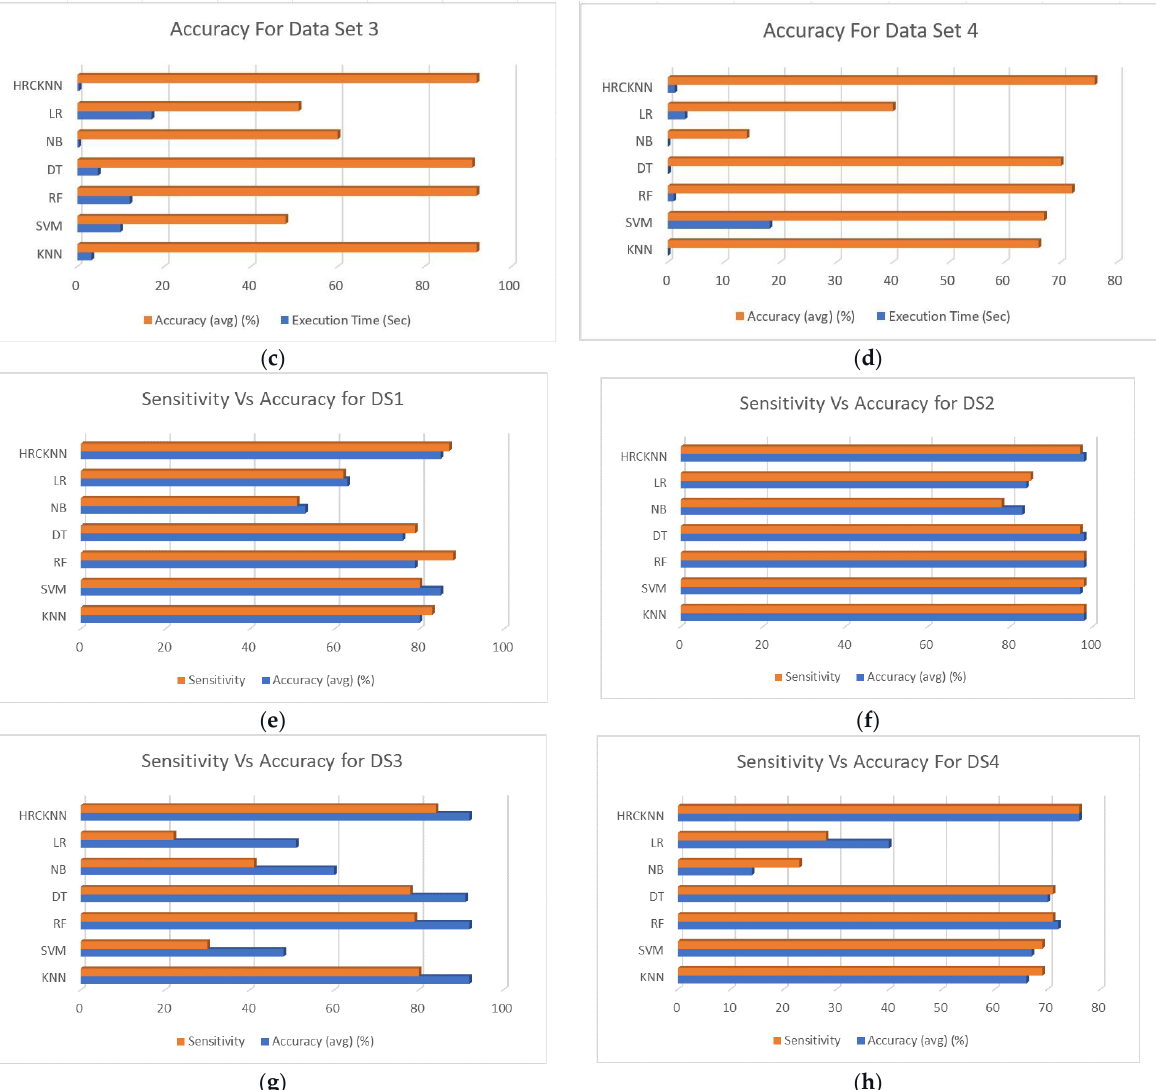
Figure 8. ( a ) Accuracy Vs. Execution Time for Dataset 1; ( b ) Accuracy Vs. Execution Time for Dataset 2; ( c ) Accuracy Vs. Execution Time for Dataset 3; ( d ) Accuracy Vs. Execution Time for Dataset 4; ( e ) Sensitivity Vs. Accuracy for Dataset 1; ( f ) Sensitivity Vs. Accuracy for Dataset 2; ( g ) Sensitivity Vs. Accuracy for Dataset 3; ( h ) Sensitivity Vs. Accuracy for Dataset 4.